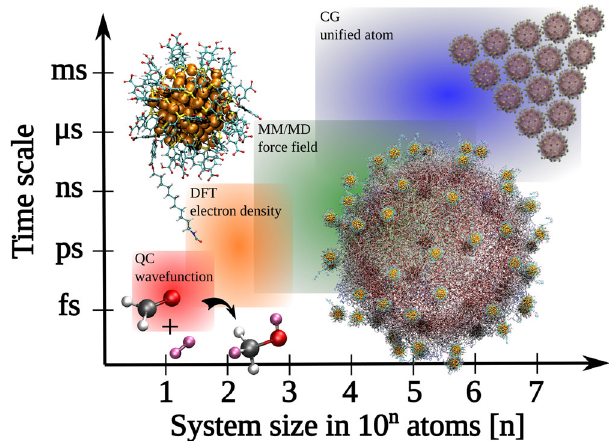
Fig. 1 System size vs. time scales and relevant simulation methods from molecules to self-assembled nanostructures. Quantum-chemical (QC) methods can conveniently deal with small molecules with great